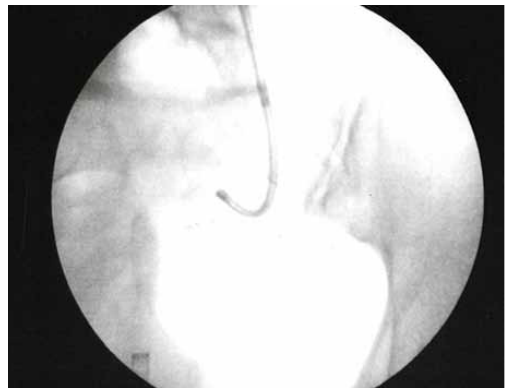
Figure 2 - ureteroscope deflection in distal ureter.